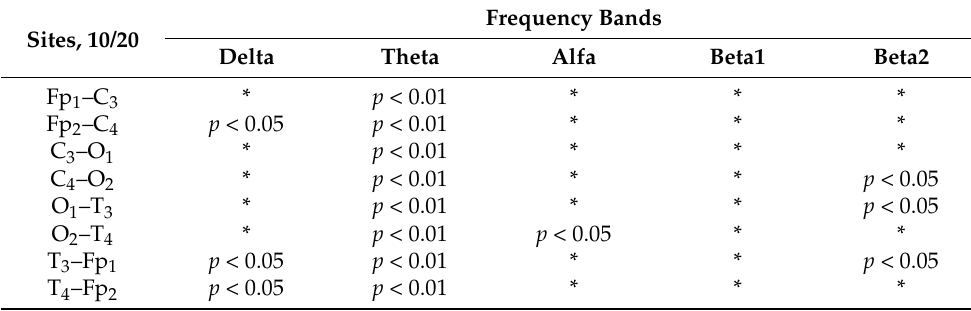
Table 4. Statistical significance of EEG indices.